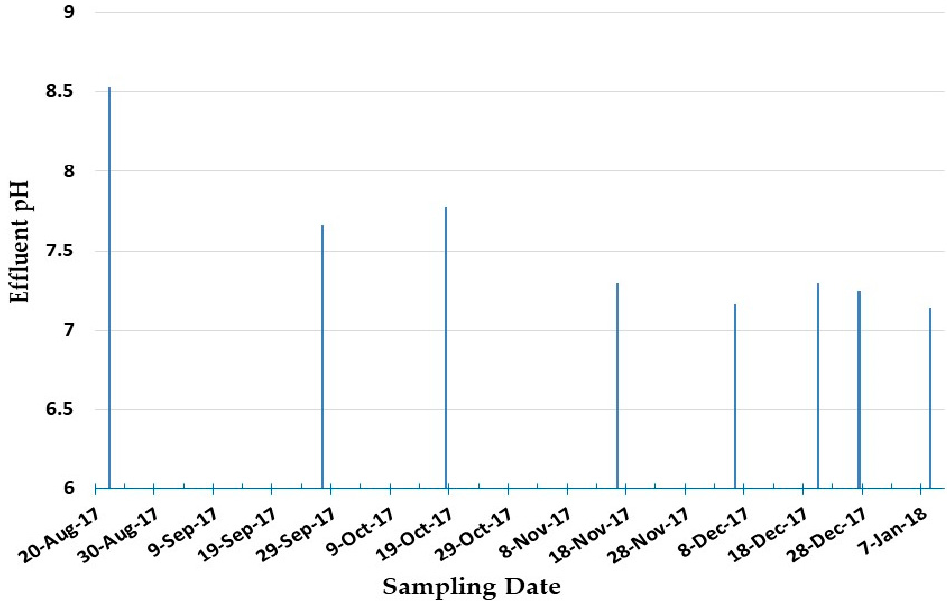
Figure 7. Effluent pH results of samples collected from 22 August 2017 to 8 January 2018.